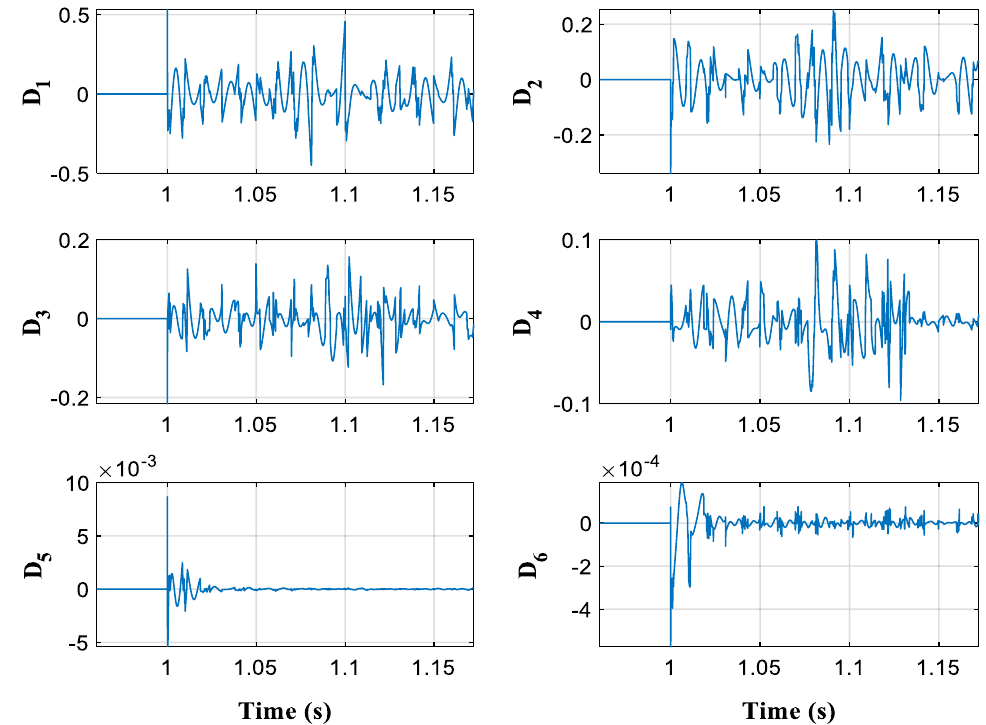
Fig. 5 The decomposition results of an inter-turn fault ( µ = 0.05 ), the largest eigenvalue is related to D 1 and the other components of three-phase stator currents are defined in the same